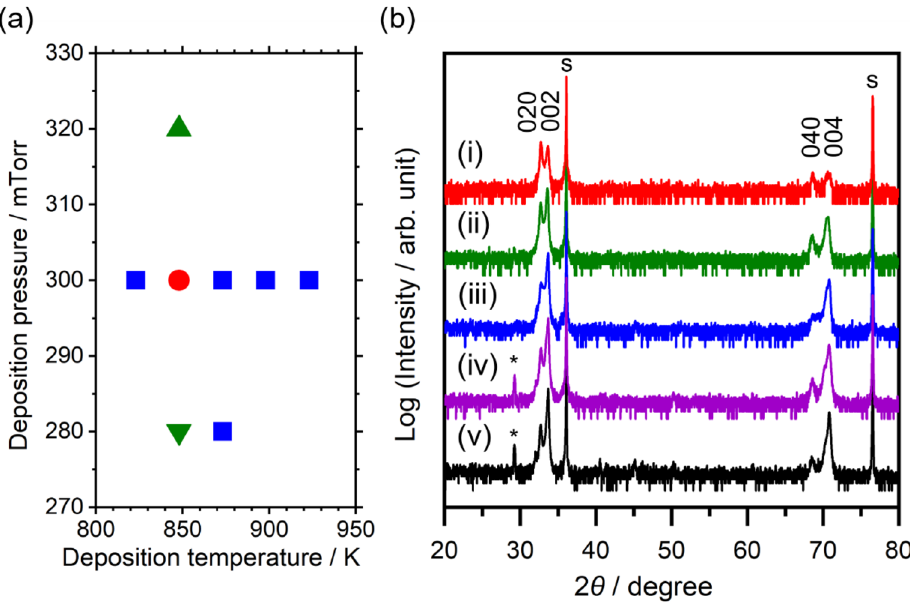
Figure 1. ( a ) Process window for BSO deposition on (101)Nb:TiO 2 . Symbols show as follows. ● : (010)/ (001)-orientation, ▲ : (010)/(001)-orientation with (411)-orientation, ▼ : (010)/(001)-orientation with (411)- and (100)-orientation, ■ : (100)-orientation. ( b ) XRD patterns for BSO/(101)Nb:TiO 2 with various film thicknesses deposited at 848 K and an O 2 atmosphere of 300 mTorr. (i) 100 nm, (ii) 220 nm, (iii) 300 nm, (iv) 430 nm, and (v) 670 nm. “*” and “s” in the figure indicate peaks attributable to the 311 reflection, and to the substrate, respectively. The X-rays were directed parallel to [010] TiO2 .